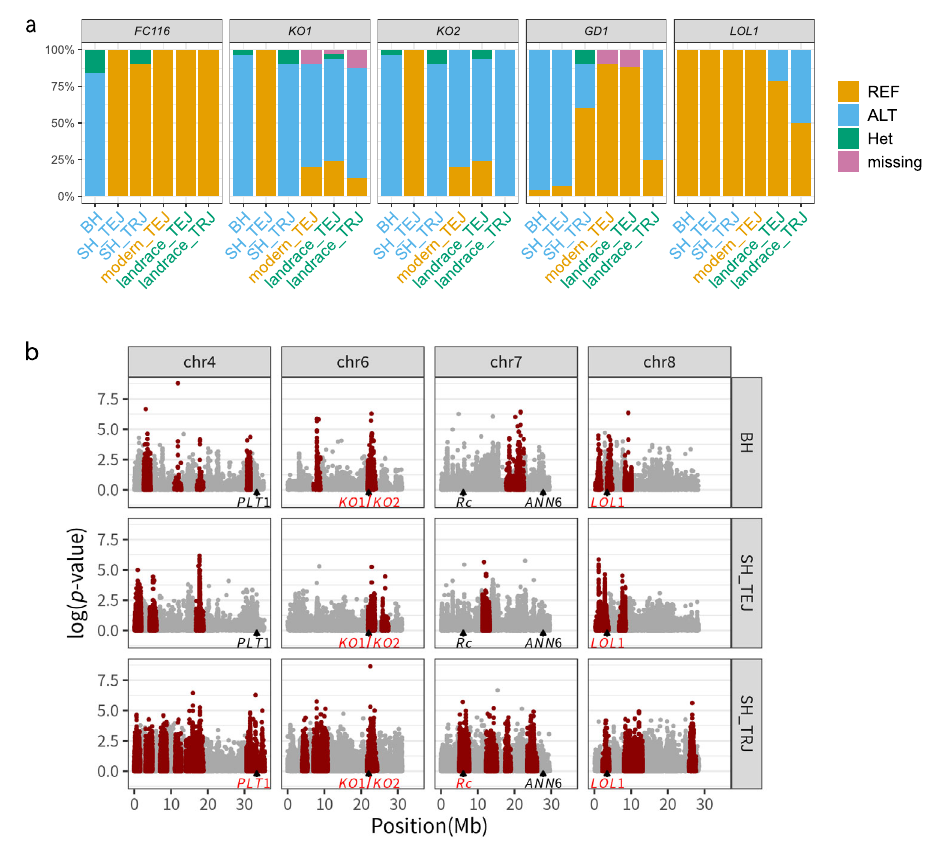
Fig. 4 Characterization of the signi fi cantly differentiated genes regulating plant height and/or endogenous bioactive gibberellins. a Frequency of variants for nonsynonymous variants in FC116 , KO1 , KO2 , GD1 and LOL1 . Detailed information is provided in Supplementary Table 2. BH, frequency in 25 BH weedy rice strains; SH_TEJ, frequency in 15 SH_TEJ weedy rice strains; SH_TRJ, frequency in 10 SH_TRJ weedy rice strains; modern_TEJ, frequency in 10 modern_TEJ cultivated rice strains; landrace_TEJ, frequency in 33 landrace_TEJ cultivated rice strains; landrace_TRJ, frequency in 8 landrace_TRJ cultivated rice strains. b Plot of iHS score (the associated p -values are indicated instead of the iHS score itself) against physical distance for chromosomes 4, 6, 7 and 8 to identify regions displaying strong signatures of positive selection in the BH (top), SH_TEJ (centre) and SH_TRJ (bottom) weedy rice groups. Regions under positive selection according to a threshold of p < 0.0001( − log10( p -value) > 4.0) are shown in dark red. The black triangles on the bottom correspond to candidate genes ( PLT1 , KO1 , KO2 , Rc , ANN6 and LOL1 ) located in shared differentiated regions between BH and SH_TRJ or BH and SH_TRJ as identi fi ed by F ST values (Fig. 3), and candidate genes in the regions under positive selection as detected by the iHS test are shown in dark